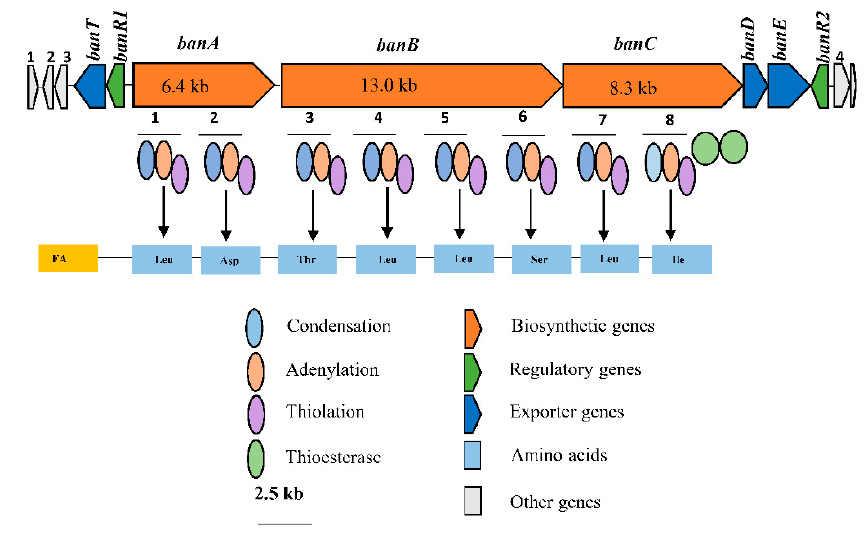
Figure 4. In silico analyses of NRPS gene clusters encoding bananamides D–G. Gene clusters comprising three structural NRPS genes, designated banA , banB and banC responsible for bananamide D-G biosynthesis in COW3. Detailed comparison of bananamide D-synthetases and flanking gene protein sequences are shown in Table S1. Each module contains an adenylation (A), condensation (C) and thiolation (T) domains, and two TE domains for peptide release and cyclization. Scale bar represents 2.5 kb.